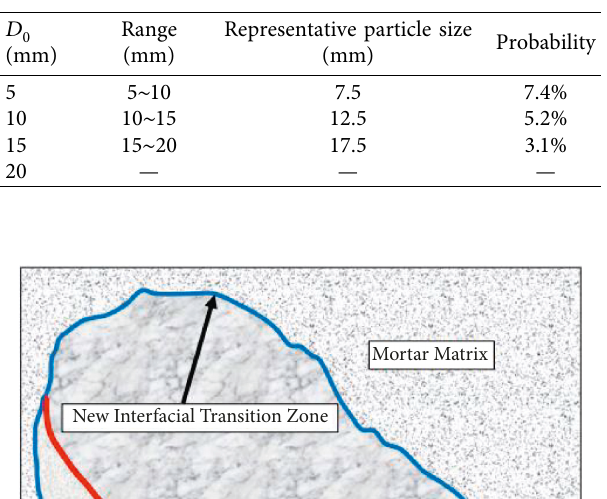
Table 1: Probability of particle size range distribution.